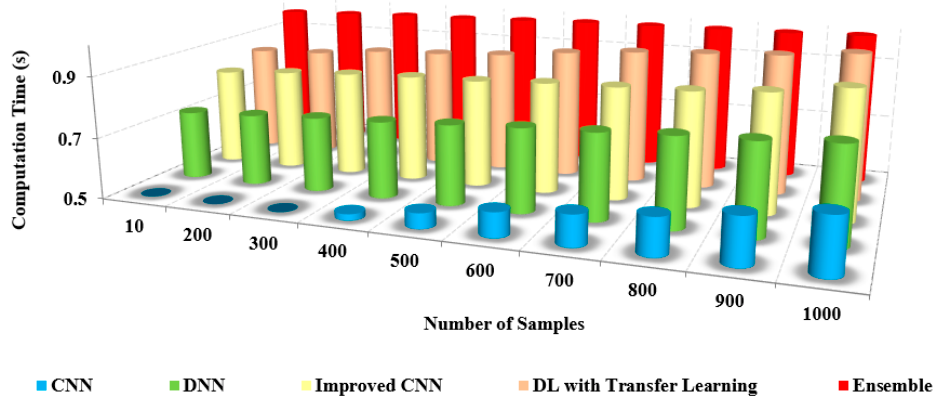
Figure 15. Number of samples vs. computation time.